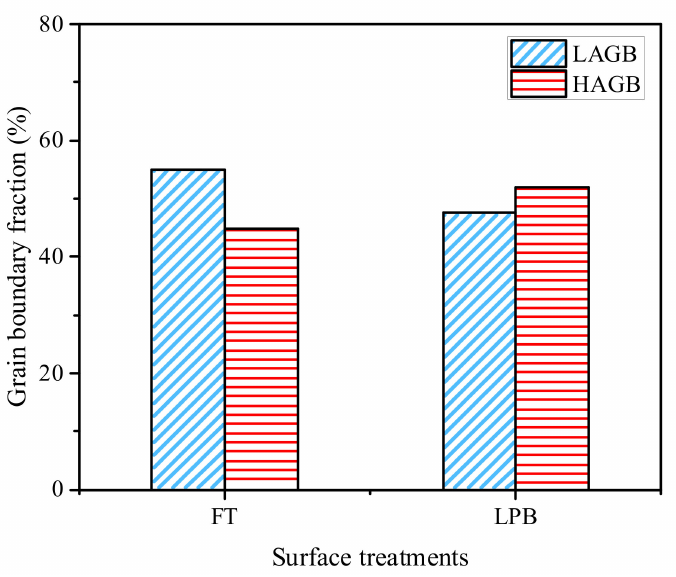
Figure 8. Grain boundaries fraction after ( a ) FT and ( b ) LPB